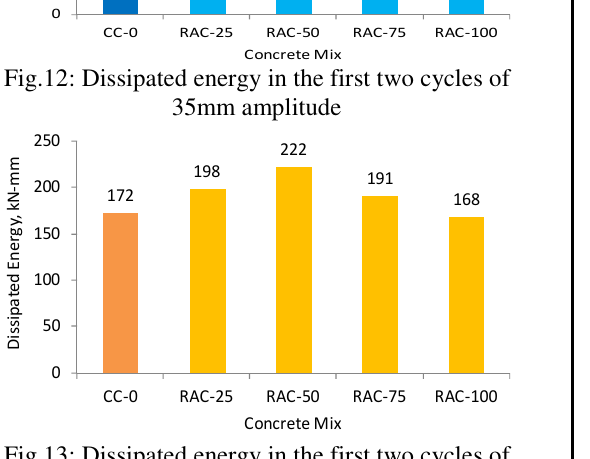
Fig.13: Dissipated energy in the first two cycles of 6mm